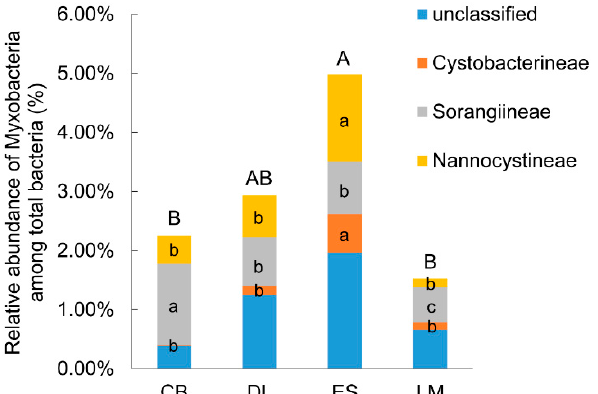
Figure 1. The relative abundance and community composition at the suborder level of soil myxobacteria among total bacteria from subtropical and tropical forest soil. The different uppercase letters above each column indicate significant difference of total myxobacteria abundance among sampling sites, and the different lowercase letters embedding the center of each stacking indicate significant difference of each suborder abundance among sites ( p < 0.05, Tukey’s multiple range test). CB, Chebaling (subtropical forest soil); DL, Diaoluoshan (tropical forest soil); ES, Esongling (tropical forest soil); LM, Limushan (tropical forest soil).